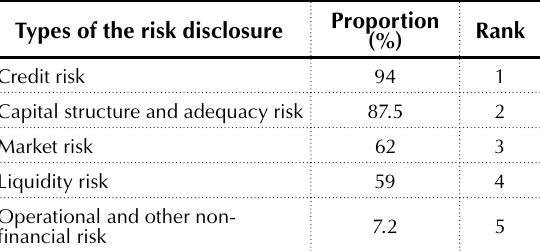
Table 5. Types of the risk disclosure